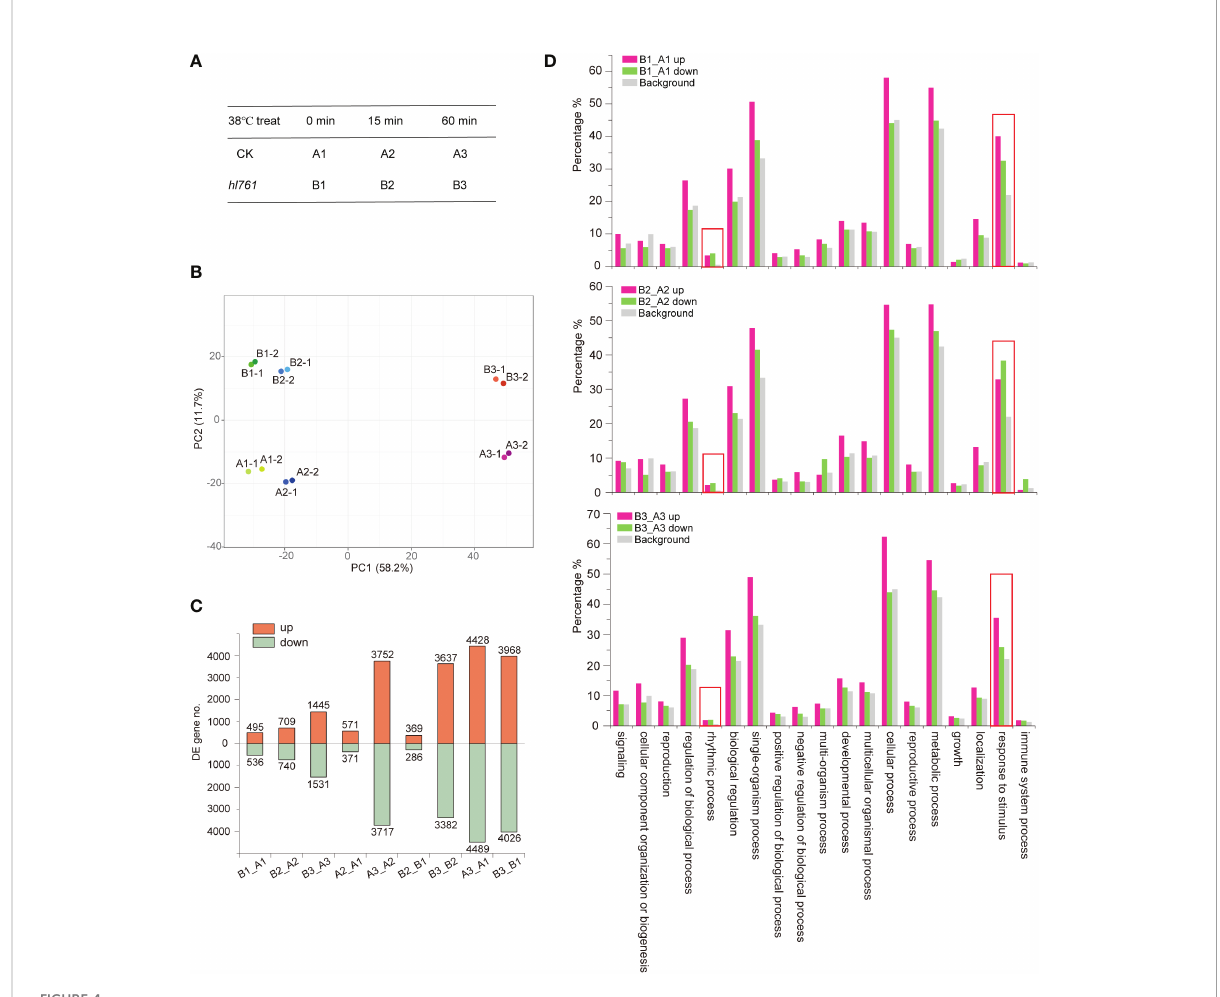
FIGURE 4 Heat stress triggers gene expression changes in plants. (A) The heat stress experiment design for RNA-seq. (B) Principal component analysis (PCA) of samples for sequencing. (C) Differentially expressed gene (DEG) numbers between different samples. Boxes up the 0 axis of y value represent upregulated DEGs, and boxes below the 0 axis represent downregulated DEGs. The number of DEGs is indicated outside the boxes. (D) Gene Ontology (GO) annotation analysis for the biological function of DEGs of hl761 vs. CK (B_A) at three time points of heat treatment. CK, background line for hl761. The y-axis represents the gene fraction of the GO